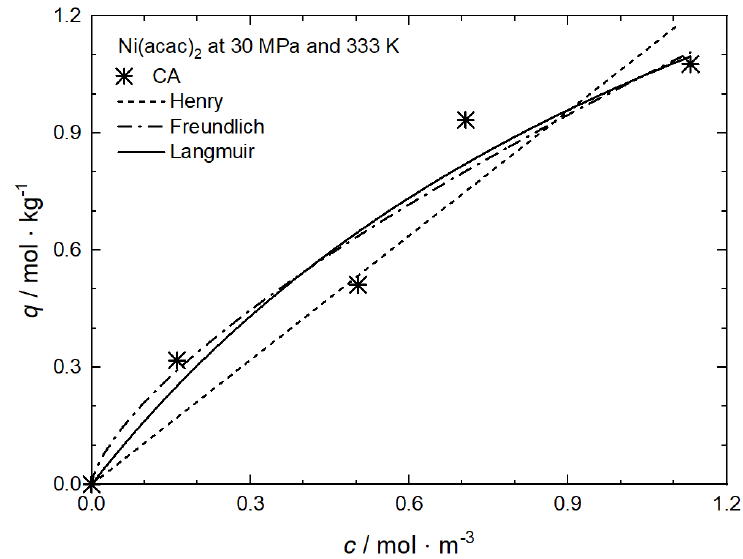
Figure A22. Uptake of Ni(acac) 2 on CA at 30 MPa and 333 K for different precursors; experimental data taken from [65]. Table A22. Adsorption isotherm parameters for Ni(acac) 2 from scCO 2 solution on CA at 30 MPa and 333 K of different precursors [65].